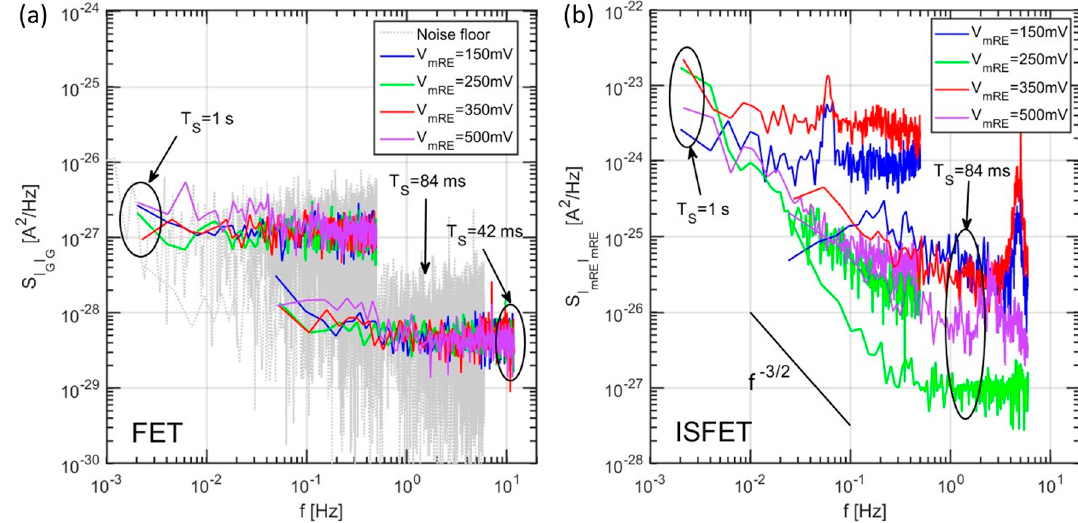
Figure 14. Noise PSDs of the metal ( a ) and liquid gate ( b ) current. The floor PSD is evaluated from an open-circuit measurement of the setup, performed applying to each probe the same bias which was used for the characterization of the leakage currents. Note that different y-axis scales are used in ( a , b ), respectively.